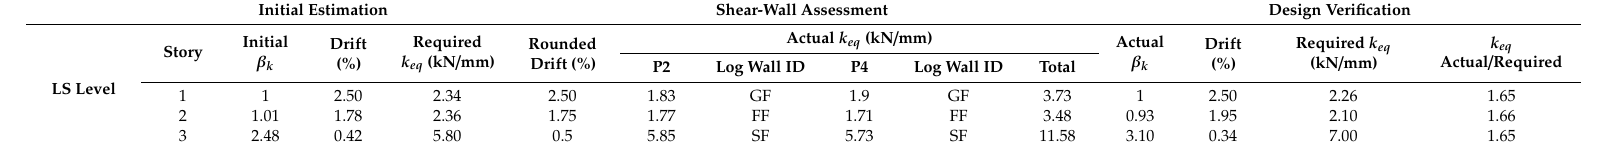
Table 8. LS level analysis (Y-direction), accounting for the EP shear-wall sti ff nesses.